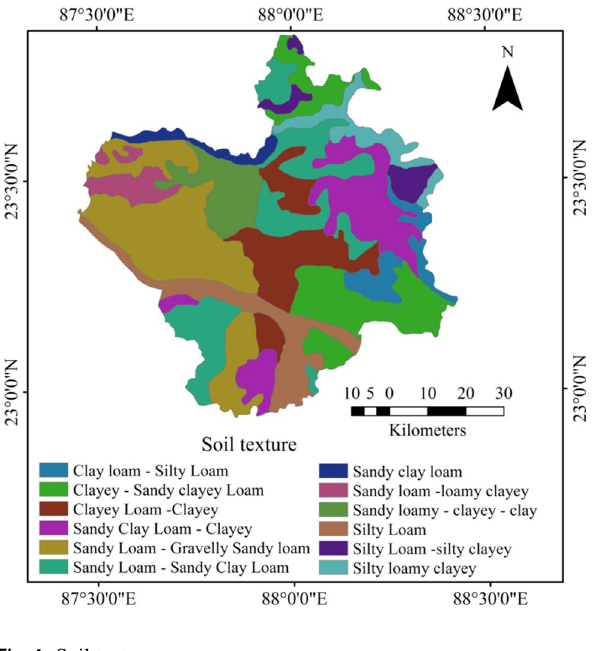
Fig. 5 Buffer zone from River